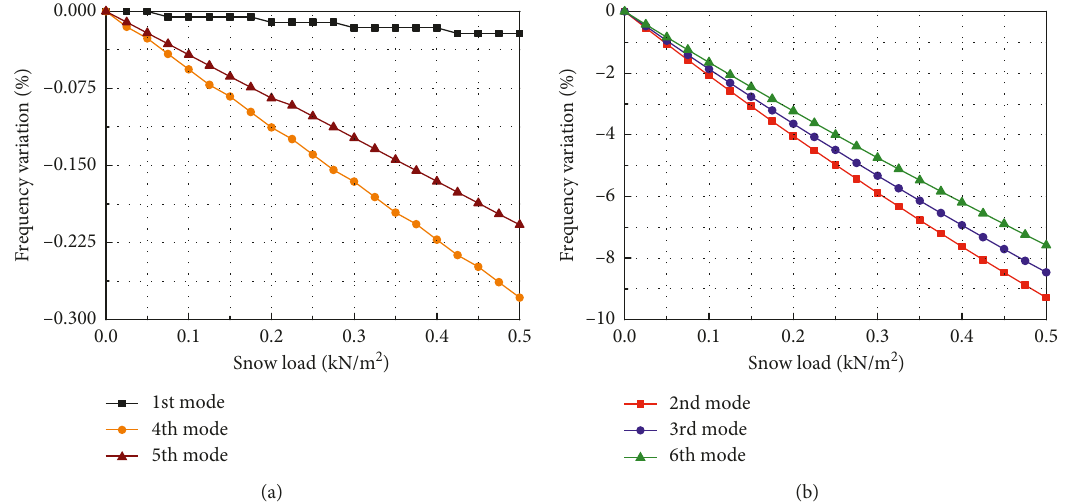
Figure 28: Frequency variations under nonuniformly distributed snow load: (a) the 1st, 4th, and 5th modes and (b) the 2nd, 3rd, and 6th